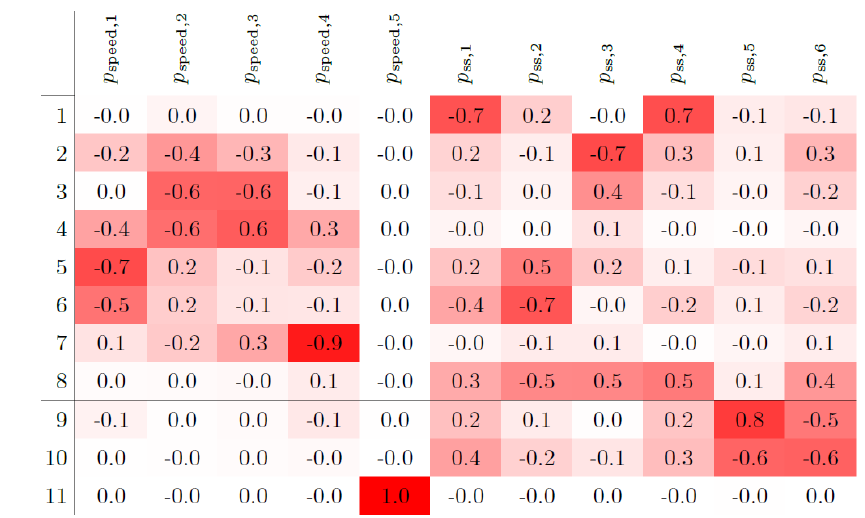
Figure 6. Variance of the orthogonal parameters before (a) and after (b) the first iteration. The identifiable orthogonal parameters are shown in red, whereas all others are shown in blue. Table 3. Transformation matrix V T after the first iteration. Each row corresponds to a different orthogonal